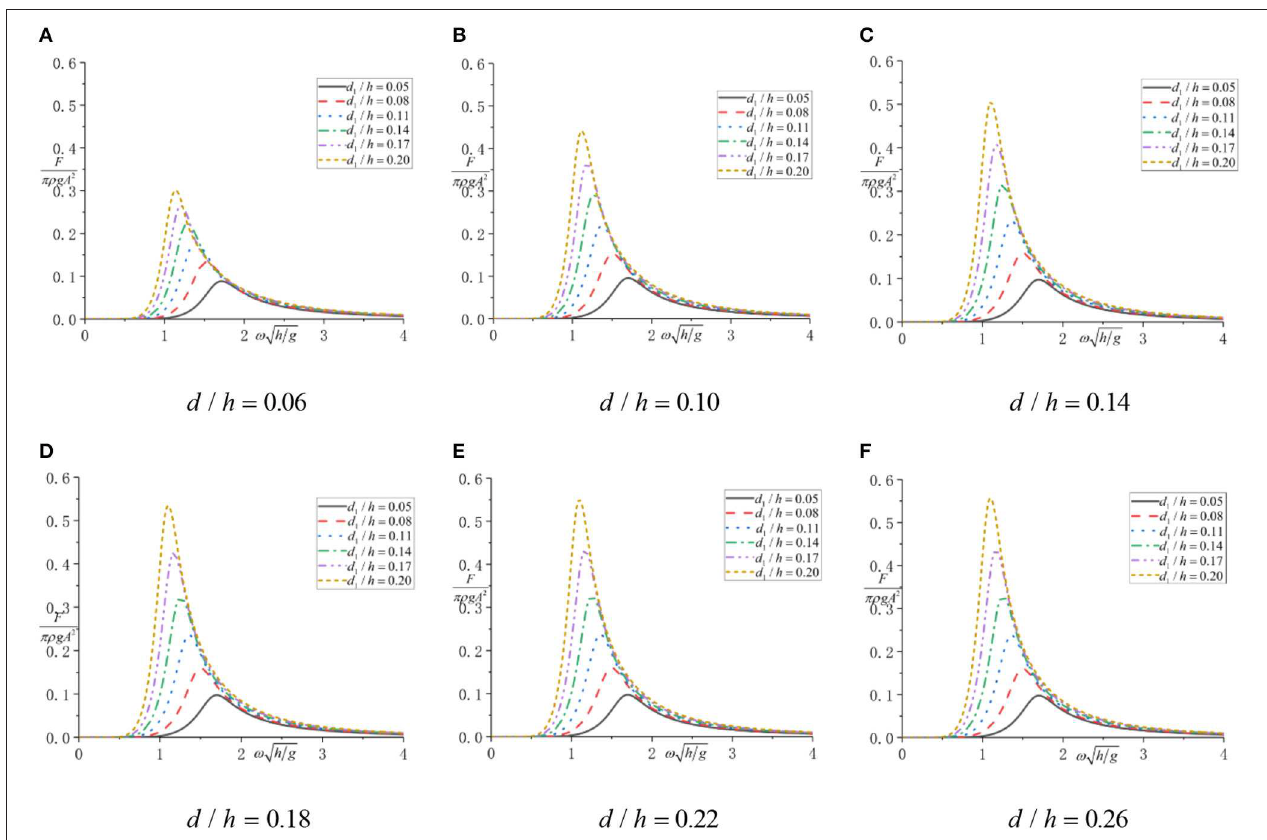
FIGURE 5 | Wave force under different oscillating water column (OWC) structural parameters. (A) d / h d / h 0.22; (F) d / h = =